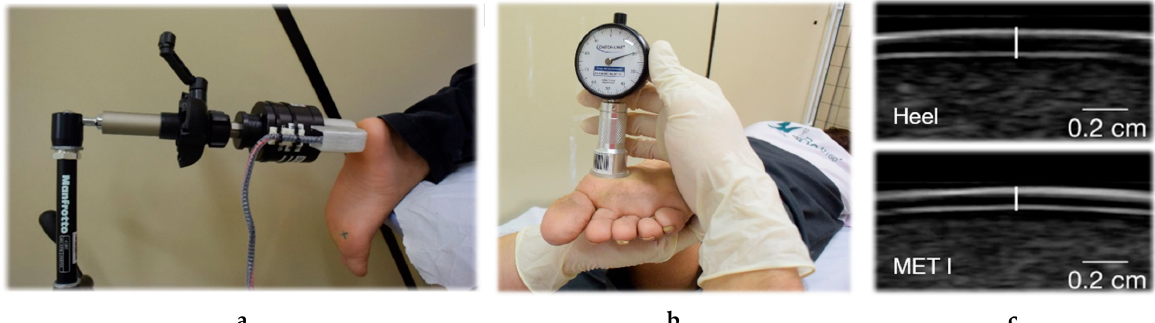
Figure 1. Measurement setup for quantifying the relationship between vibration sensitivity and mechanical skin properties. ( a ) Measuring vibration perception thresholds with the customized vibration exciter. ( b ) Measuring skin hardness with a handheld Durometer. ( c ) Quantifying skin thickness with a handheld ultrasound transducer at the heel and first metatarsal head (MET I) [18].